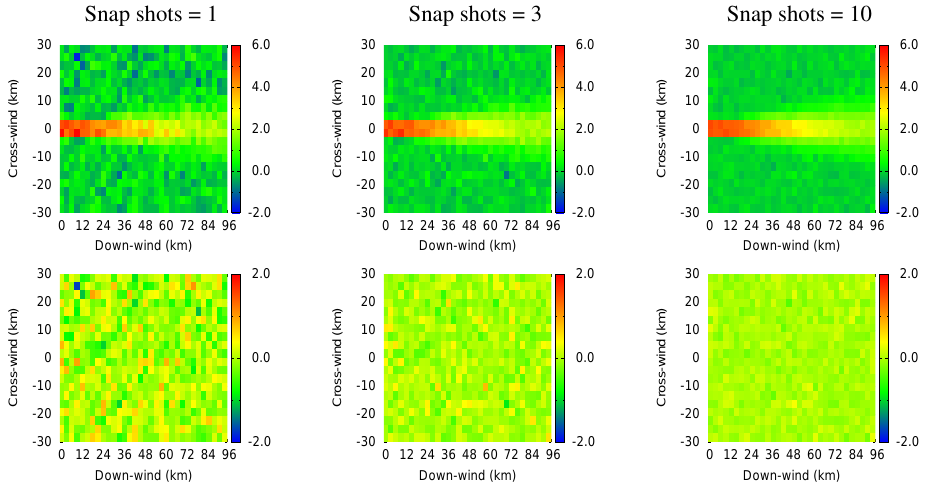
Fig. 18. The upper row shows the retrieved enhancements (in ppm) of X CO 2 above the background estimated from one, three and ten snap-shots. The lower row shows the corresponding errors (in ppm). The plume from the power plant is assumed to be clean (devoid of aerosol). The x- and y-axes are distances in km. The power plant is located at (0 , 0) . The wind is from the west with speed 1 ms − 1 .